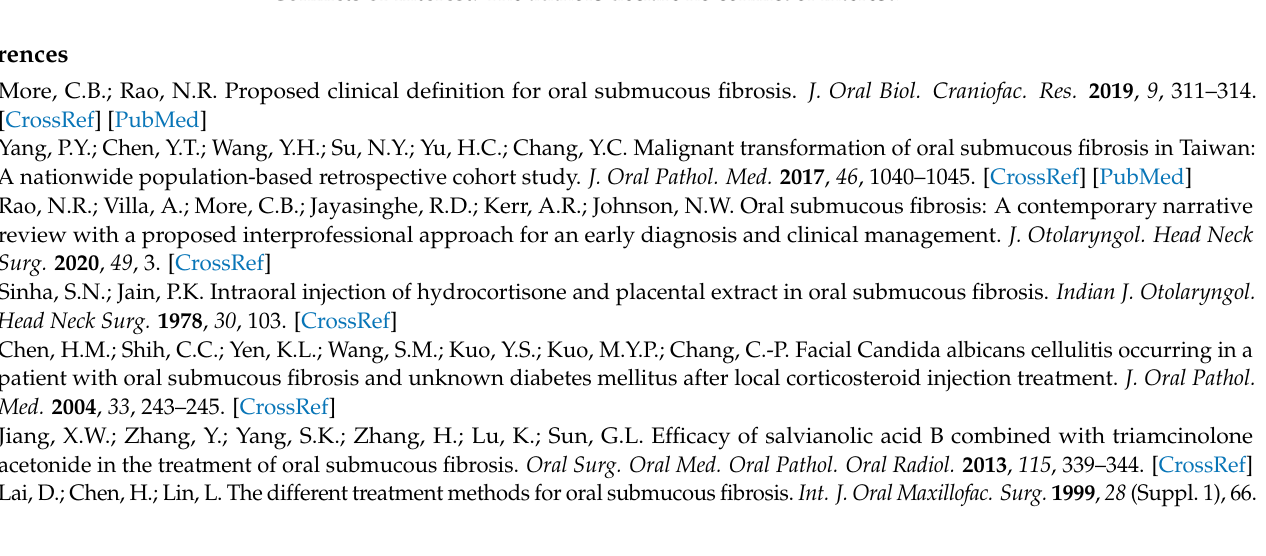
Table S6 Global inconsistency test (burning sensation), Table S7 Local inconsistency test: the SIDE approach (node splitting), Figure S1 Loop-specific approach to assess the inconsistency in a network, Figure S2 Forest plot illustrating the mean improvement in mouth opening between lycopene and controls (other interventions), Figure S3 Forest plot illustrating the mean improvement in mouth opening between combination therapy of hyaluronidase and corticosteroids with controls (other interventions), Figure S4 Forest plot illustrating the mean improvement in mouth opening between curcumin and controls (other interventions), Figure S5 Forest plot illustrating the mean improve- ment in mouth opening between Aloe vera and controls (other interventions), Figure S6 Forest plot illustrating the reduction in burning sensation between Lycopene and controls (other interventions), Figure S7 Forest plot illustrating the reduction in burning sensation between curcumin and controls (other interventions), Figure S8 Funnel plot illustrating the mean improvement in mouth opening between lycopene and controls (other interventions), Figure S9 Funnel plot illustrating the mean im- provement in mouth opening between combination therapy of hyaluronidase and corticosteroids with controls (other interventions), Figure S10 Funnel plot illustrating the mean improvement in mouth opening between curcumin and controls (other interventions), Figure S11 Funnel plot illustrating the mean improvement in mouth opening between Aloe vera and controls (other